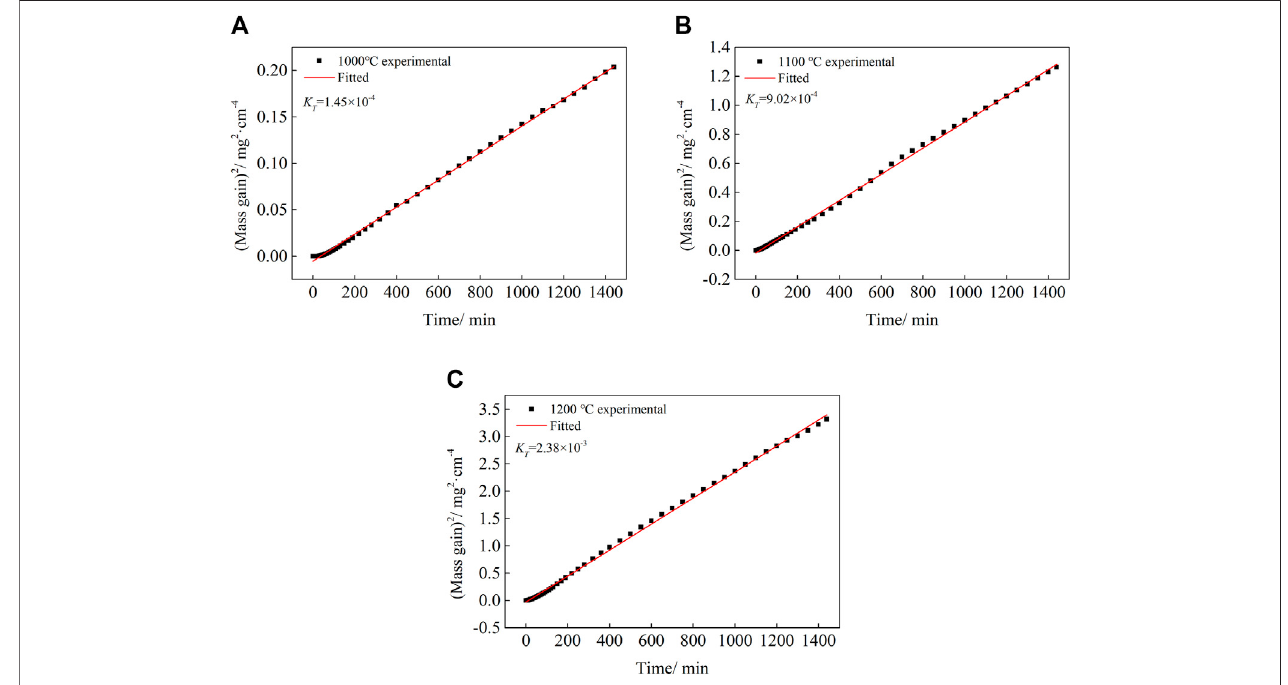
FIGURE 4 | Linear fi tting of oxidation kinetics of Co-20Re-25Cr-3Si alloy at different temperatures: (A) 1,000 ° C, (B) 1,100 ° C, (C) 1,200 ° C.